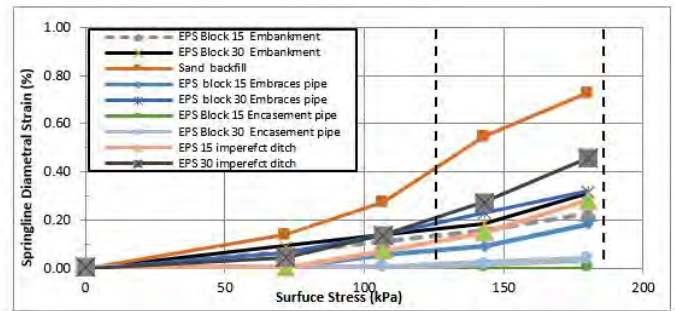
Figure 13. Springline diametral strain of UPVC buried pipe in case of different backfill